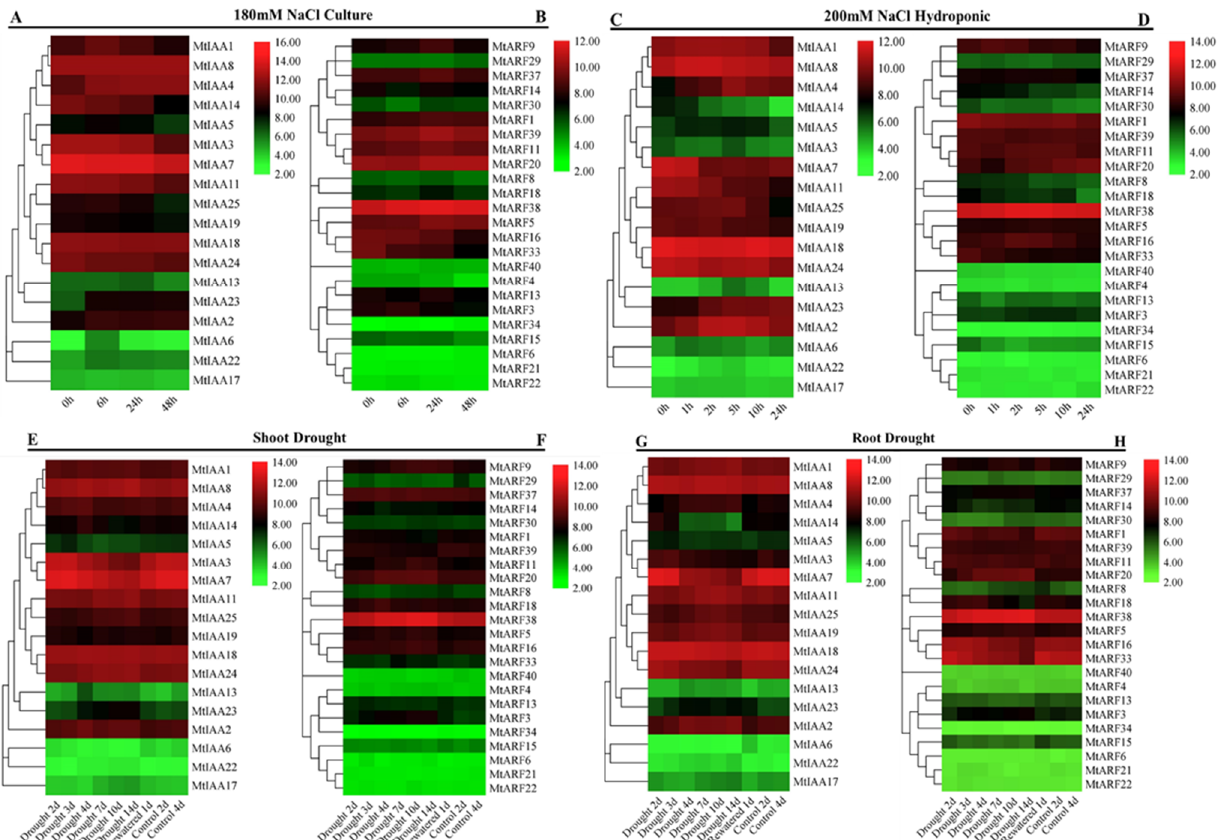
Figure 6. Responses of MtIAAs and MtARFs’ expression to salt and drought stress. The microarray data were retrieved from M. truncatula Gene Expression Atlas (MtGEA, https://mtgea.Noble.orgv3/ (accessed on 24 January 2021)). ( A , B ) Two-day-old seedlings were treated by placing in 1/2 MS medium containing 180 mM NaCl for 0, 6, 24 and 48 h for salt stress. ( C , D ) Two-week-old seedlings were placed in a nutrient solution containing 200 mM NaCl for 1, 2, 5, 10 and 24 h as hydroponic treatment, with those growing in the nutrient solution as the control. ( E – H ) The 24-day-old seedlings growing in soil underwent withheld irrigation for 14 d of drought treatment before rewatering. MtIAAs and MtARFs expression levels are indicated as the log2-based fluorescence intensity values.